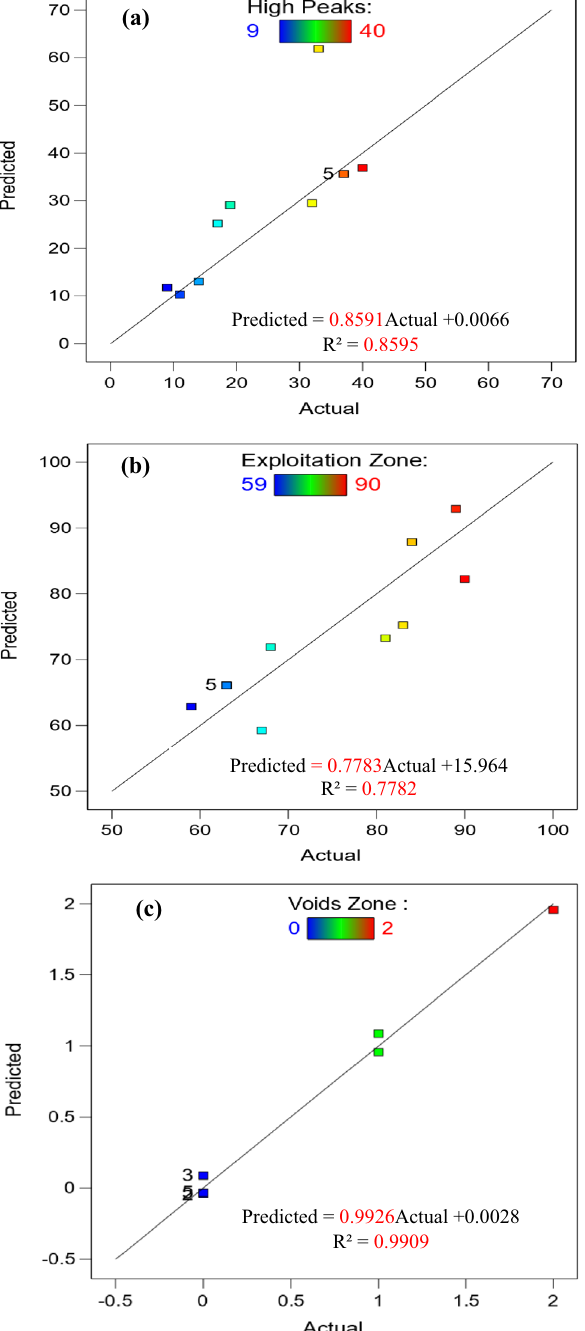
Figure 17. Relationship between actual and predicted Abbott Firestone zones of QAM f